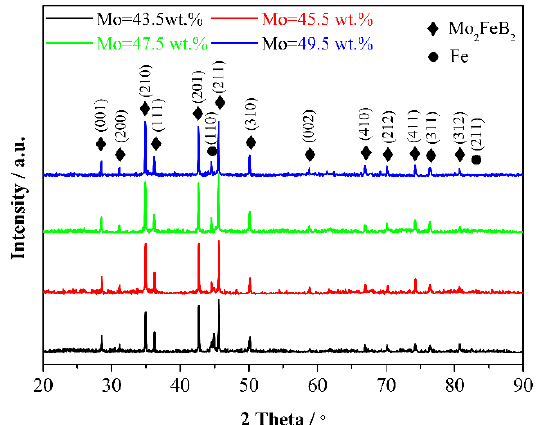
Figure 3. XRD patterns of Mo 2 FeB 2 based cermets with different Mo contents.